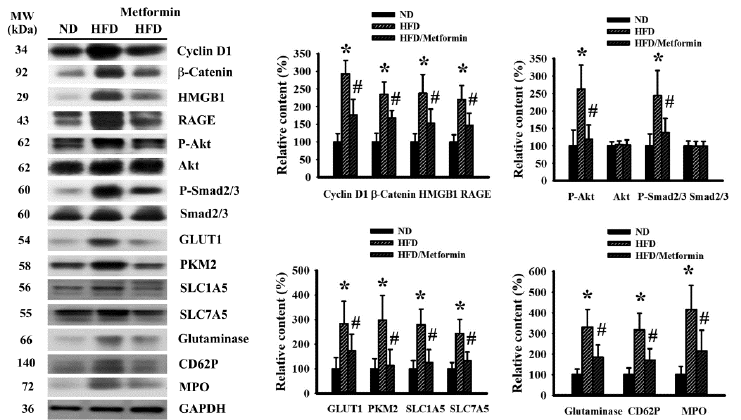
Figure 4. Metformin mitigated signaling molecule expression in tumor tissues. ND-fed lean and HFD-fed obese mice were subcutaneously inoculated with LLC cells over a course of three weeks. Three days after cell implantation, ND-fed lean mice were treated daily with saline vehicle through intraperitoneal injection (ND). HFD-fed obese mice were separated into two groups receiving daily intraperitoneal injections of a saline vehicle (HFD) or metformin (50 mg/kg, HFD/Metformin) for the final 18 days. The levels of specific proteins in the resected tumor tissues were measured using Western blot with indicated antibodies. Intensity of the specific protein was first normalized with that of GAPDH. For the calculation of relative content, the levels of normalized intensity in ND group were defined as 100%. Representative blots and quantitative data are shown. * p < 0.05 vs. ND and # p < 0.05 vs. HFD, n = 6.